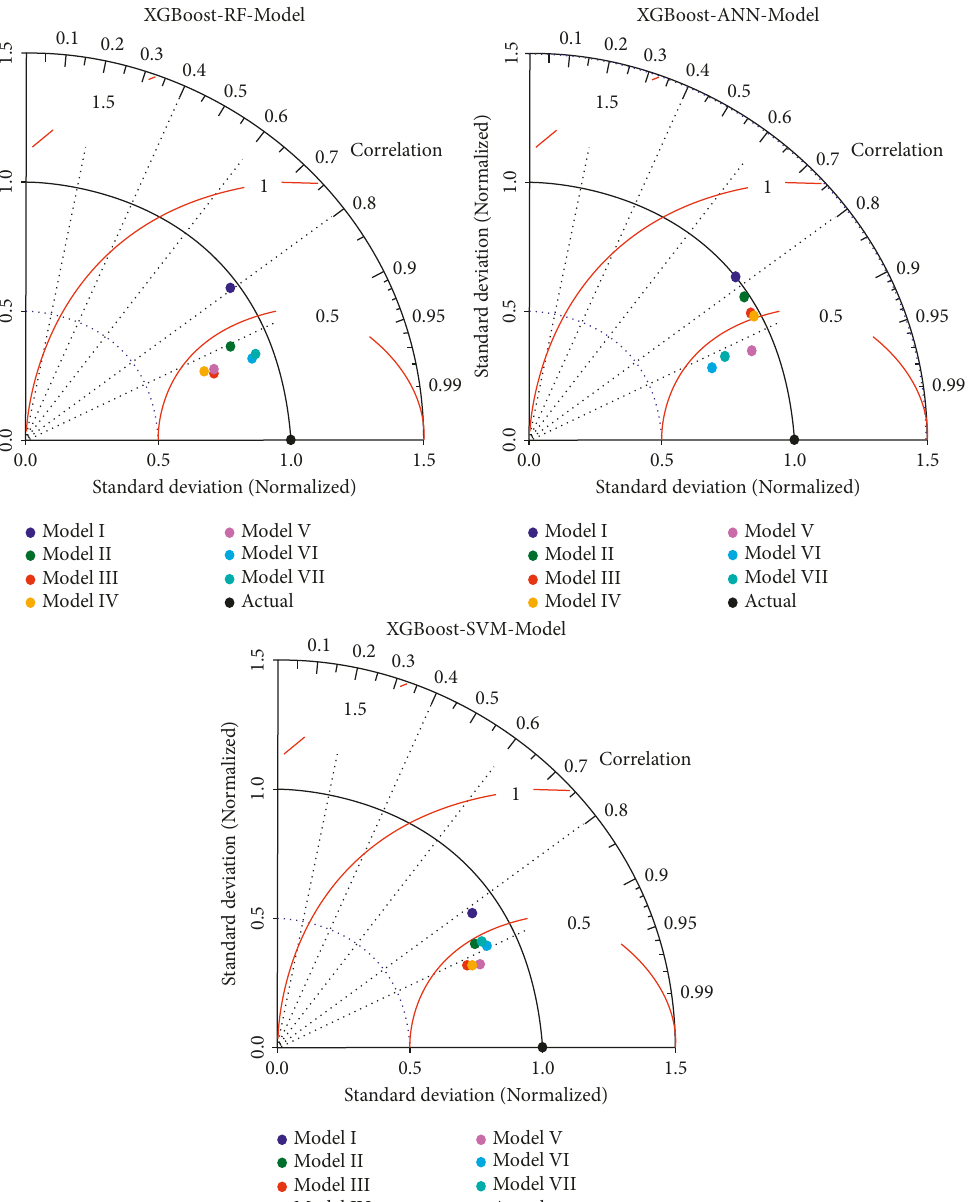
Figure 10: Taylor diagram of the developed AI models for the testing